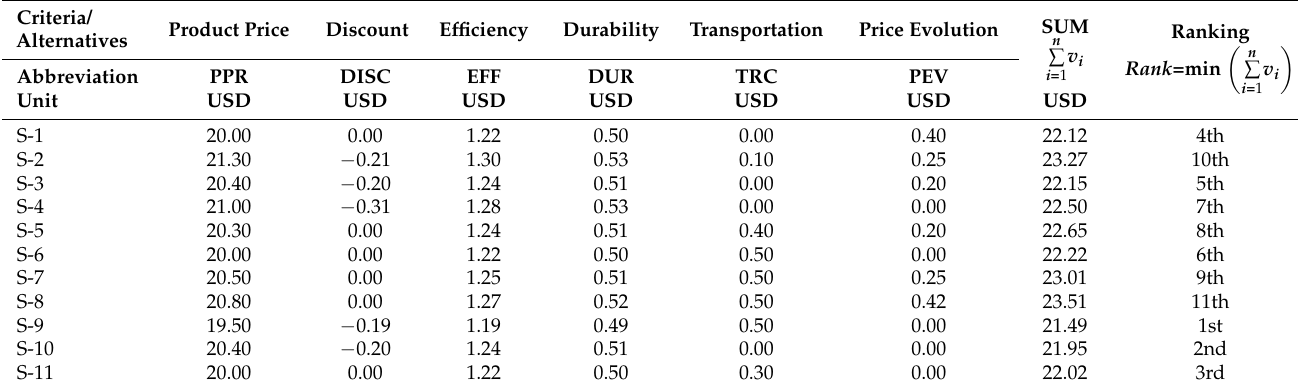
Table 5. Evaluation of Monetary Criteria for Chemical Fertilizer.